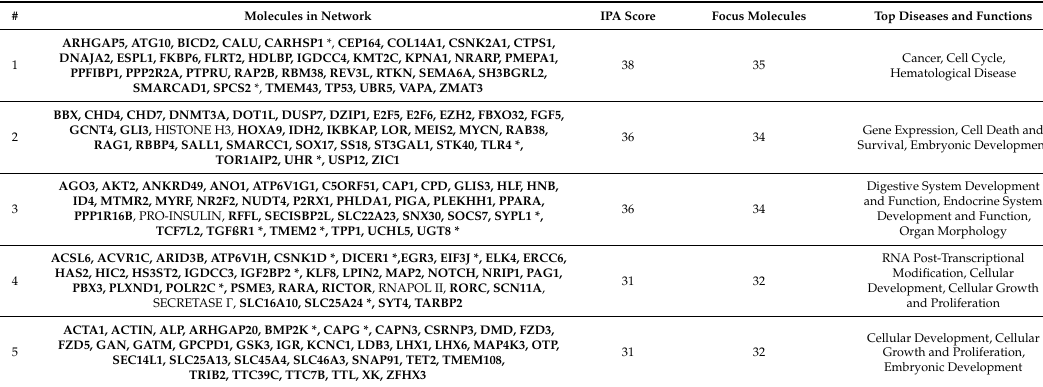
expression, organ morphology, and RNA post ‐ transcriptional modification (Table 4).